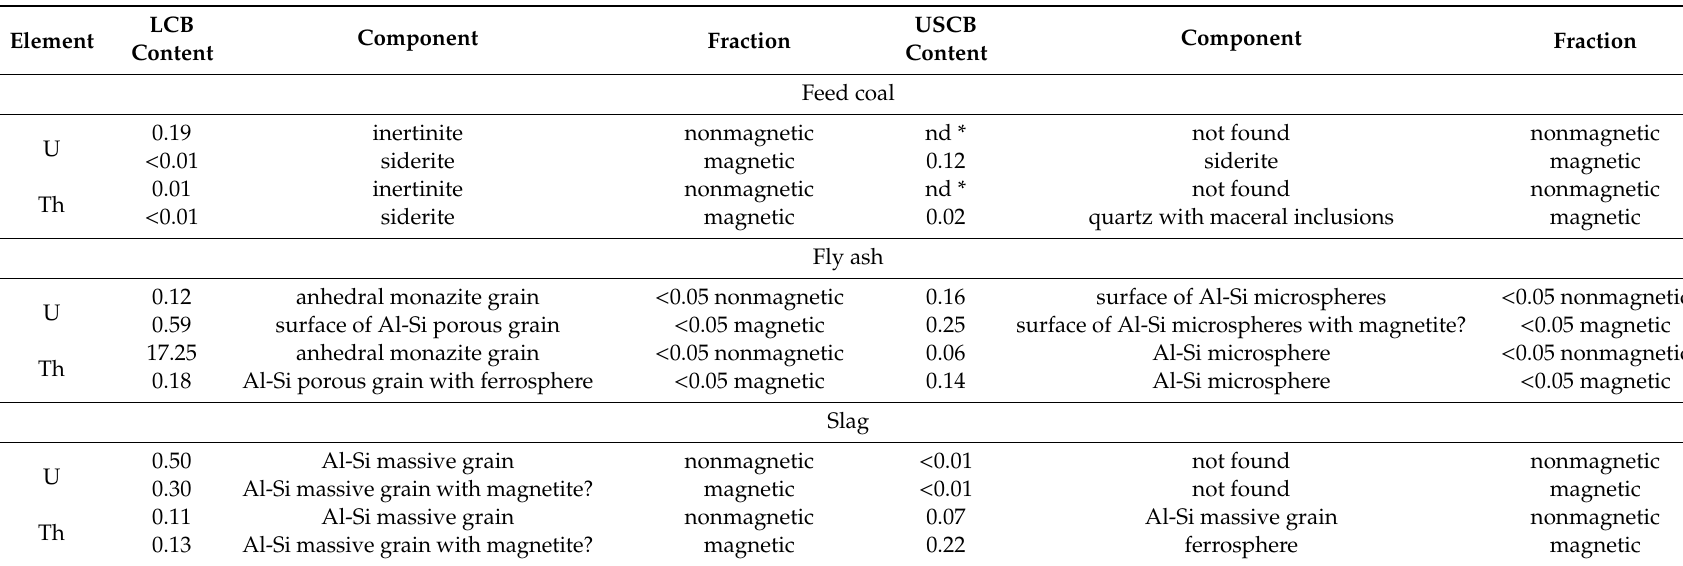
Table 3. Maximum content (wt %) of U and Th in the feed coal from the Lublin (LCB) and Upper Silesian Coal Basin (USCB) and in the fly ash and slag obtained by SEM / EDS